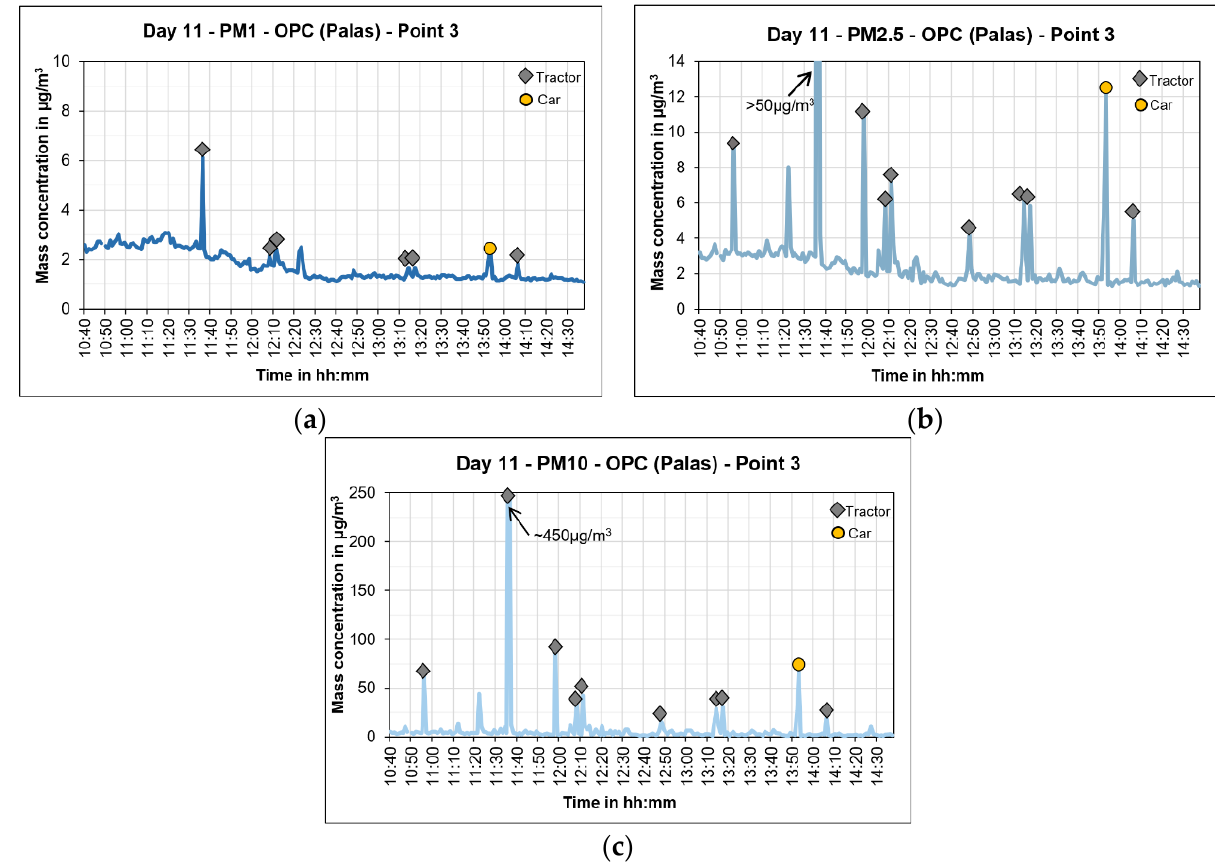
Figure 29. ( a ) PM1, ( b ) PM2.5, and ( c ) PM10 peaks from tractors.